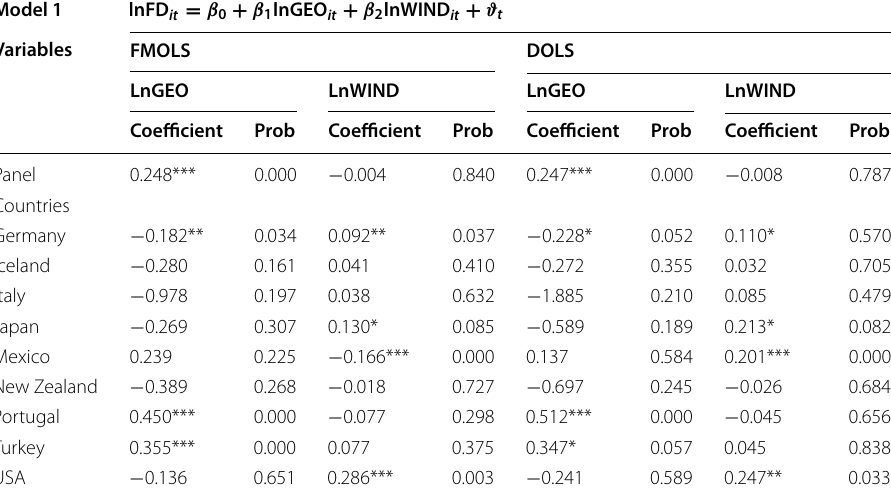
Table 5 Model 1 FMOLS and DOLS coefficient estimator results